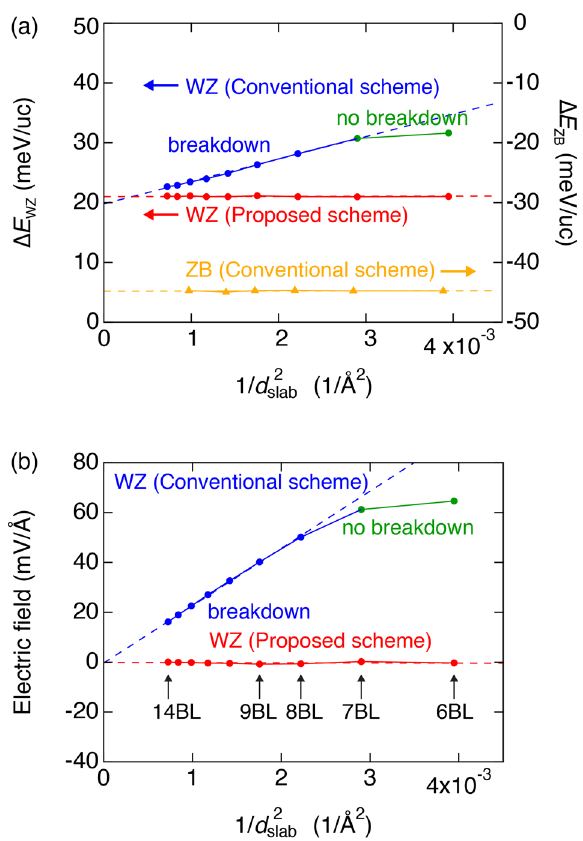
Fig. 1 Convergence of passivation schemes as a function of slab thickness. a The energy difference between two electron-counting Fig. 2 Atomic and electronic structure, and electrostatic potential reconstructions [(2 × 2)-O ad and (2 × 2)-V Zn ] on the wurtzite (WZ) energy pro fi le of a WZ ZnO(0001) slab. a Side view of a WZ ZnO ZnO(0001) and the zinc-blende (ZB) ZnO(111) surface, and b the slab, in which the O dbs on the ZnO ð 0001 Þ surface are passivated by calculated electric fi eld in a WZ ZnO(0001) slab with a (2 × 2)-O ad psH 0.5 and the ZnO(0001) surface has a (2 × 2)-O ad reconstruction. reconstructed surface, as a function of 1 = d 2 , where d slab is the slab The slab thickness d slab , the cell length L and a ZnO bilayer (BL) are thickness of the slab. The green, blue and orange points are indicated in the fi gure. b and c : The computed electrostatic obtained from calculations using the conventional passivation potential energy pro fi le and the layer-resolved density of states scheme. Systems in which the CBM on one side of the slab overlaps (LDOS) for slabs with this atomic arrangement. The slab thickness (does not overlap) with the VBM on the other side of the slab are d slab has been chosen to show b no breakdown (9 BL) and c termed breakdown (no breakdown). Also shown are results (red breakdown (13 BL). The planar- and the macroscopic-averaged points) obtained from calculations employing the proposed scheme. electrostatic potential energies are shown as blue and red solid The dashed lines are fi ts revealing the extrapolated values for an lines, respectively. The LDOS along the z axis (axis perpendicular to in fi nitely thick slab. The calculations were performed using the PBE the slab surfaces) is resolved for each Zn – O BL and shown as a gray exchange-correlation functional. region. The energy of the highest occupied state is set to 0